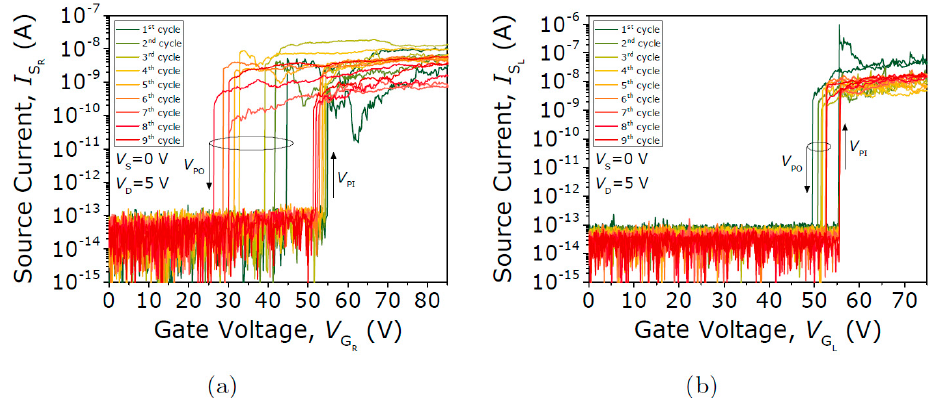
Figure 5. First nine current voltage ( I-V ) switching characteristics in ambient conditions of the ( a ) left and ( b ) right drain electrodes for the seesaw relay Type I (TiN-TiN contact).